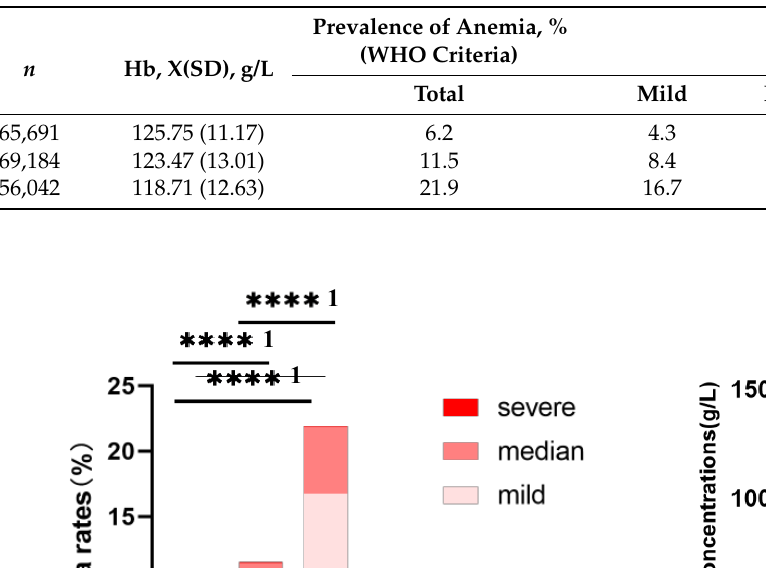
Table 3. Hemoglobin concentrations (g/L) and the prevalence of anemia (%) according to trimesters.